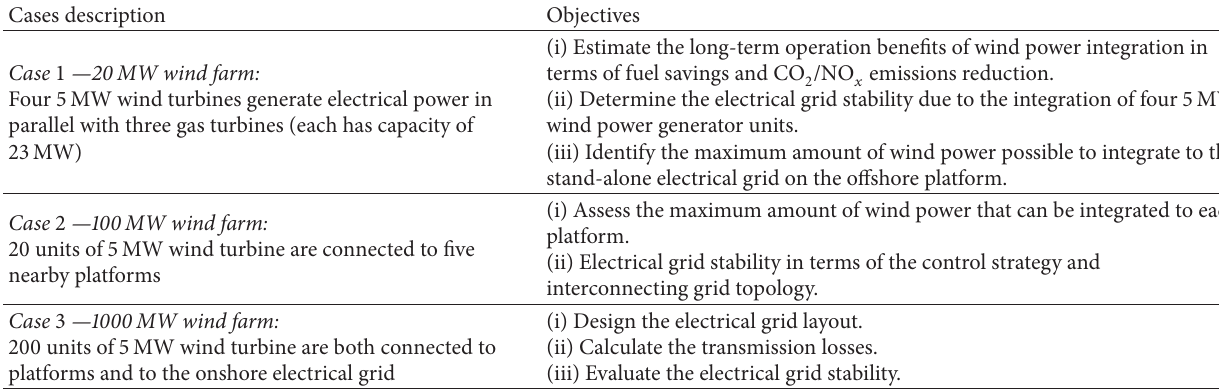
Table 1: Three study cases.